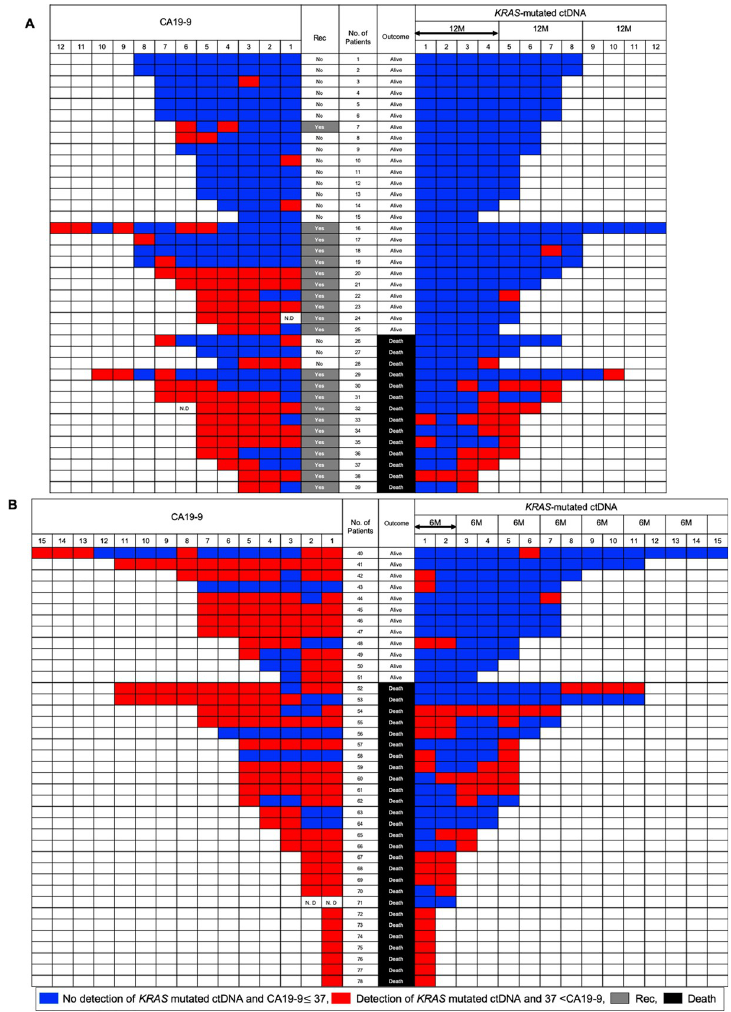
Fig 2. Sequential assessments of KRAS- mutated ctDNA and carbohydrate antigen 19–9 (CA19-9) level in longitudinal tests. (A) CA19-9 levels and the emergence of KRAS- mutated ctDNA are shown under “CA19-9” and “ KRAS- mutated ctDNA,” respectively, and are ordered as per the timing of blood examination after surgery (1 ! 12). CA19-9 � 37 U/mL and no detection of KRAS- mutated ctDNA are represented in blue, whereas CA19-9 > 37 U/mL and the emergence of KRAS- mutated ctDNA are represented in red. Recurrence is shown under “Rec,” with “no” and “yes” indicated in white and gray, respectively. Prognosis is shown under “Outcome,” with “alive” and “death” indicated in white and gray, respectively. Examination results for every 3 months are shown in one cell; thus, four cells correspond to approximately 1 year. ND, not determined. (B) Sequential assessments of KRAS- mutated ctDNA and CA19-9 levels in longitudinal tests for patients who did not undergo surgery. CA19-9 levels and the emergence of KRAS- mutated ctDNA are ordered as per the timing of blood examination (1 ! 15). Number of patients corresponds to those described in S2 and S3